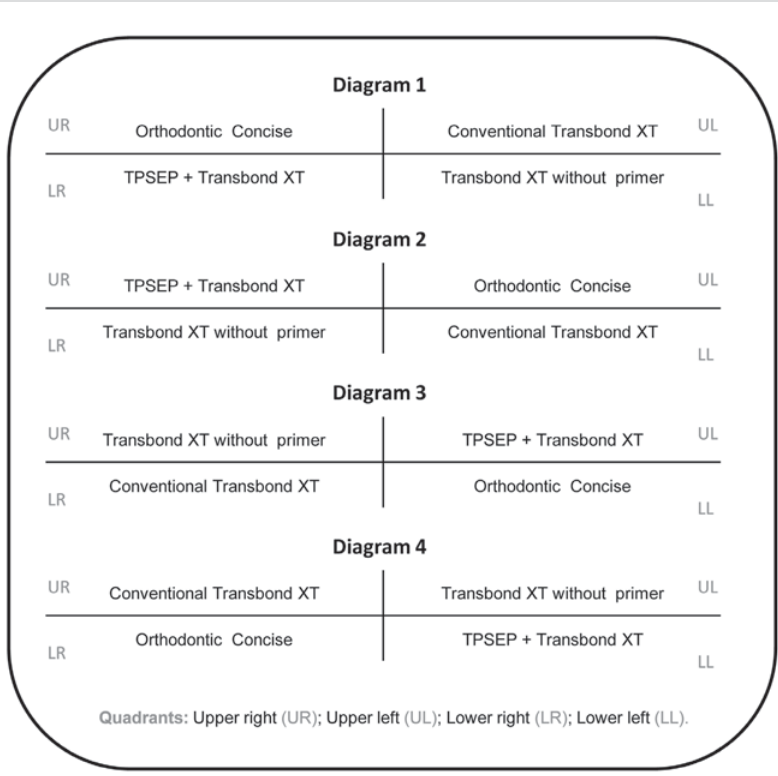
Figure 2- Distribution of adhesive systems in the four